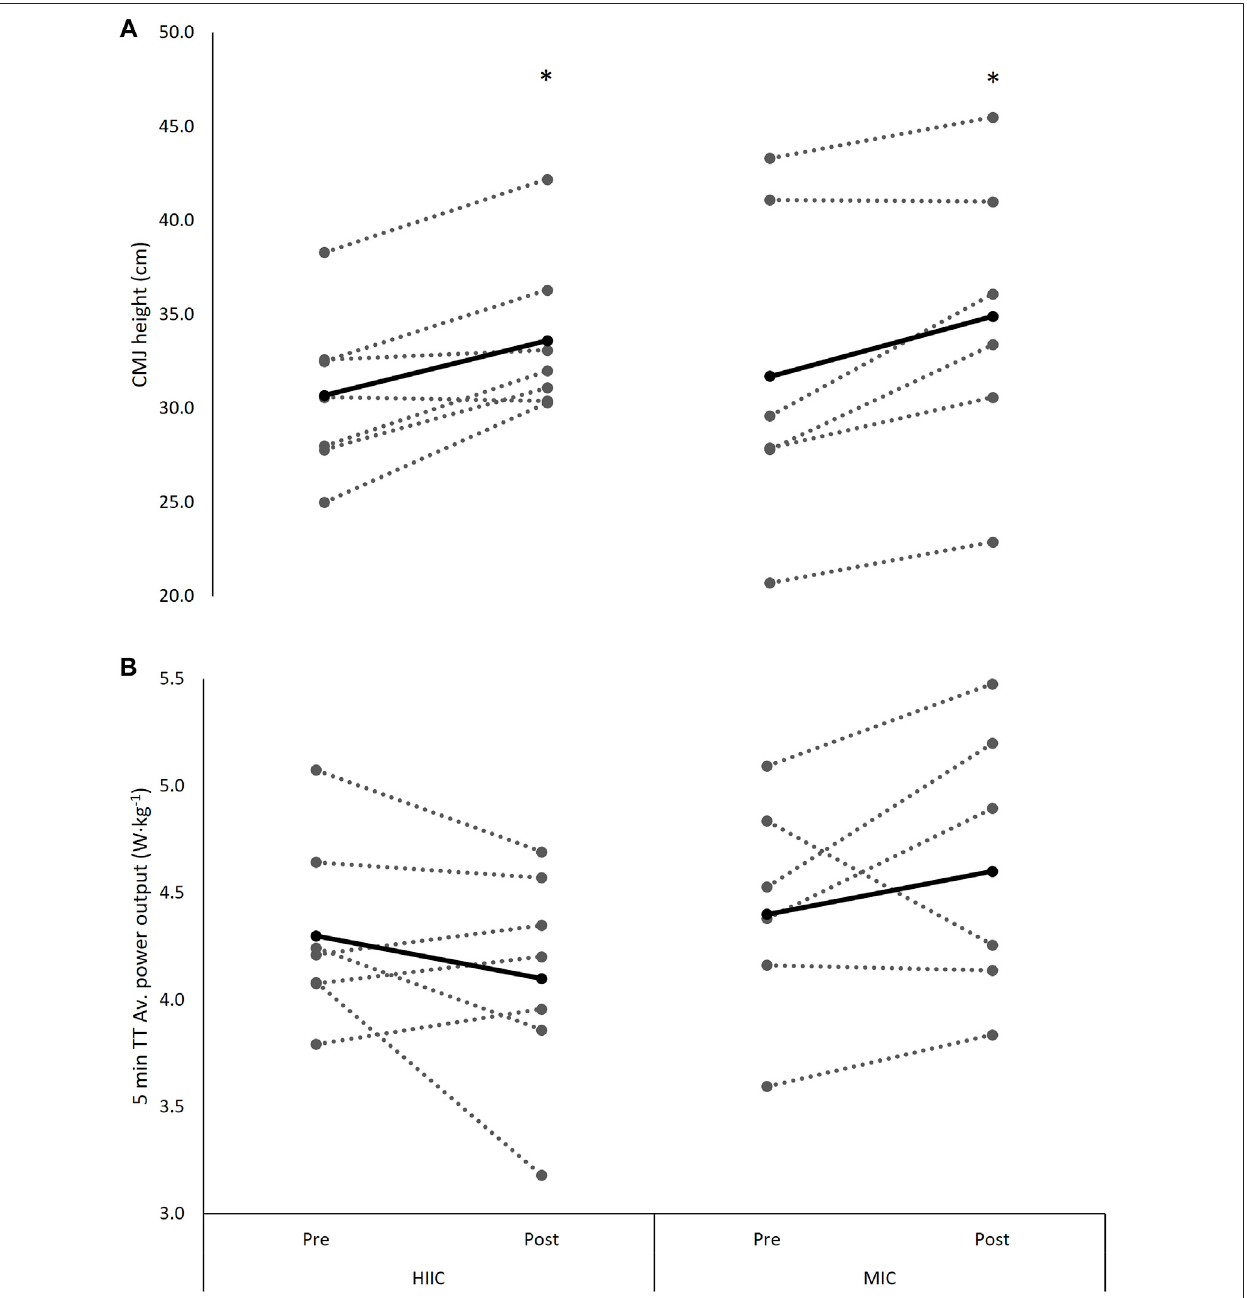
FIGURE 3 | Individual (dashed lines and grey dots) and mean (black lines and black dots) response in phosphorylation of the mTOR signaling pathway in the MICT ( n = 6) and HIIT ( n = 7) groups including representative images. Pre = pre-training intervention, post = post-training intervention, RES = resistance exercise; MICT = moderate intensity cycling; HIIT = high intensity interval